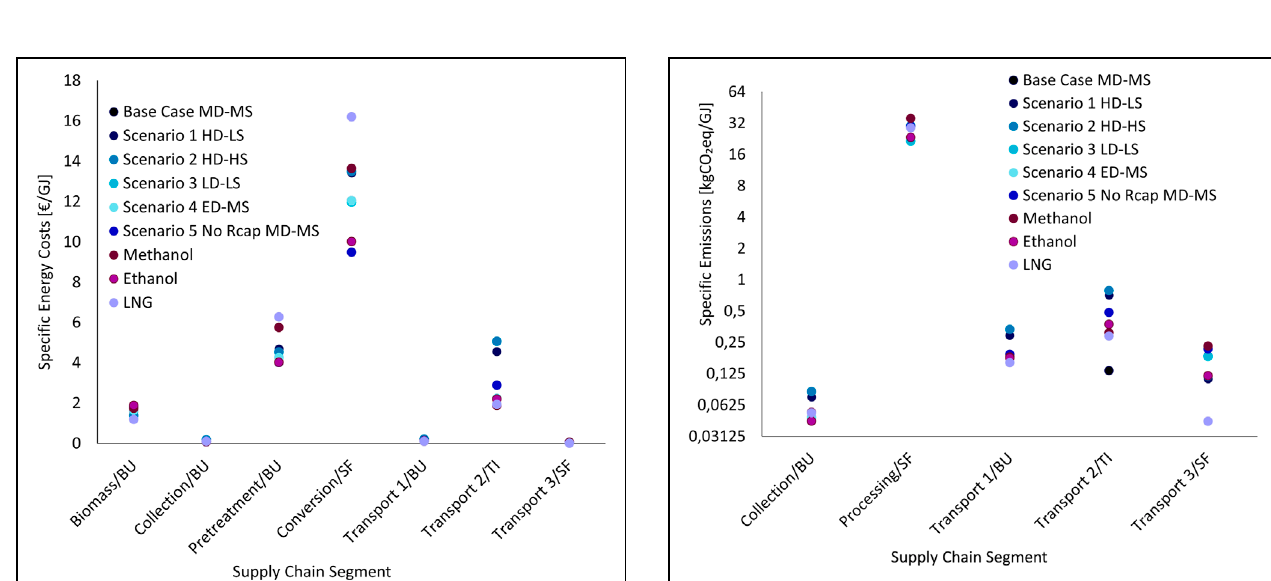
FIGURE 5 | Marginal costs of emission abatement.